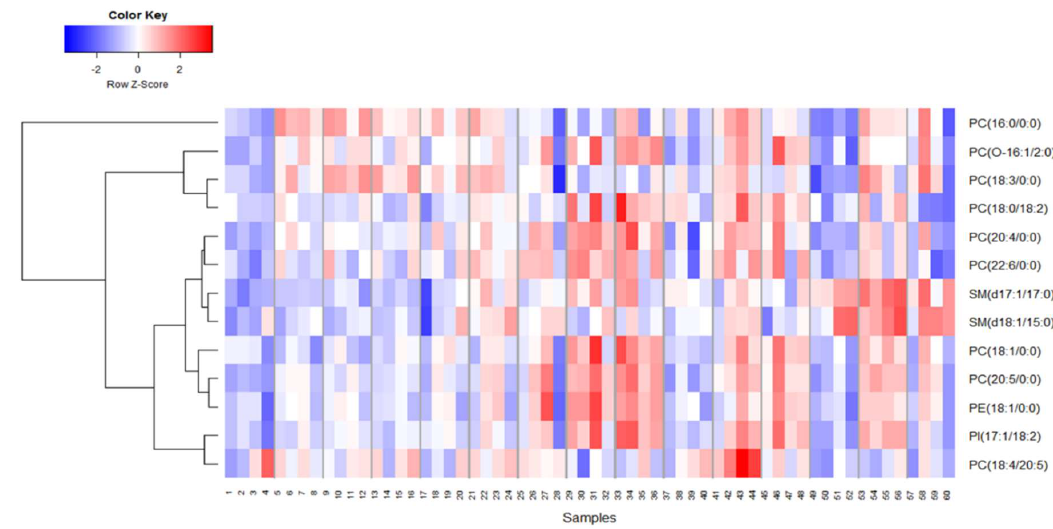
Figure 5. Longitudinal changes in lipid profiles unique to im administration of BIO 300 in NHPs indicate that most changes are transient.